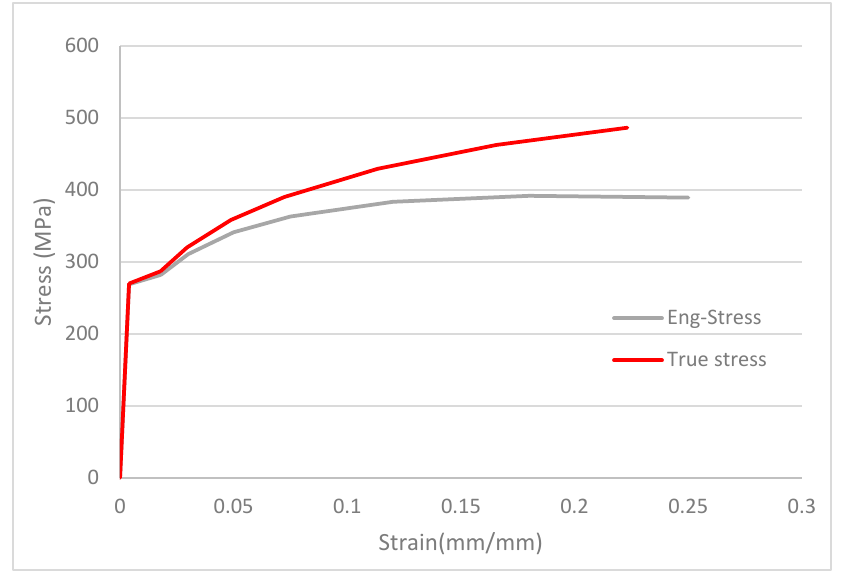
Figure 13. Stress–strain curves.